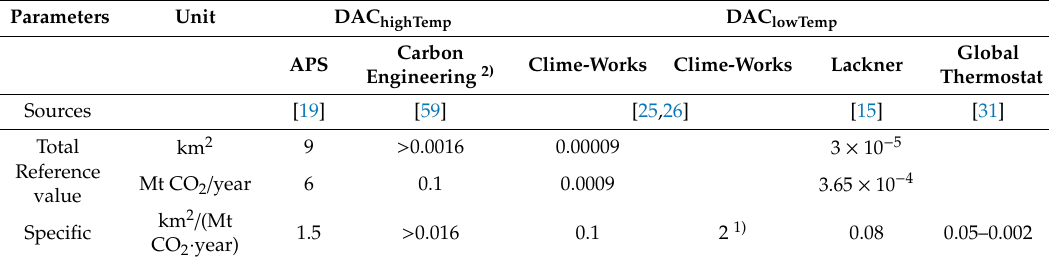
Table 5. Specific land use of the various types of Direct Air Capture (DAC) processes (not including the area set aside for energy generation